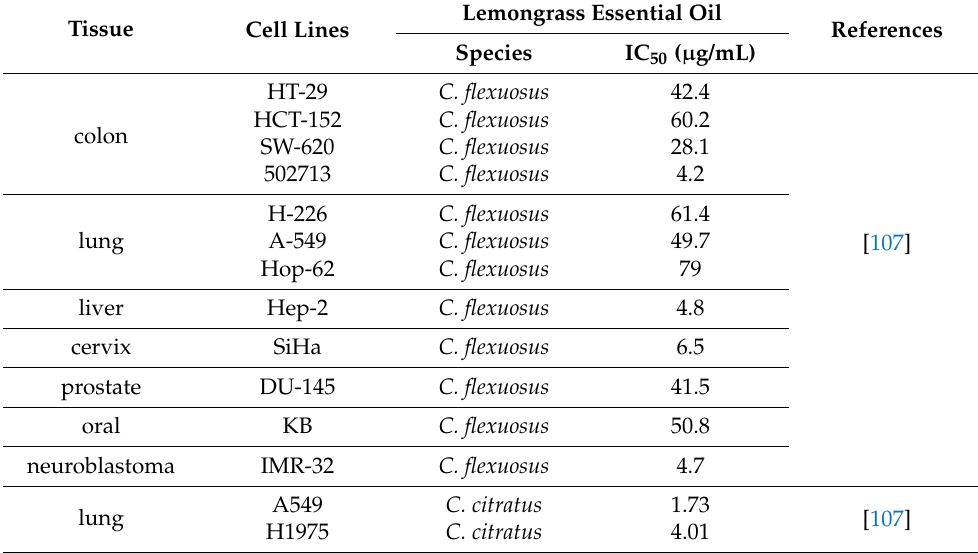
Table 4. Efficacy of essential oils obtained from different lemongrass species against various cancer cell lines. IC 50 , half maximal inhibitory